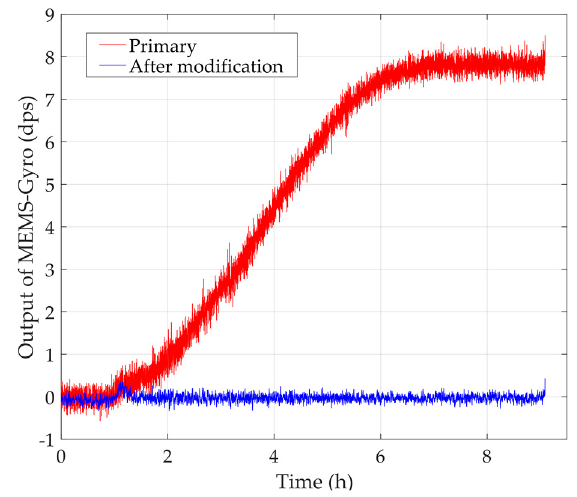
Figure 11. Primary outputs of MEMS-gyros and its compensated outputs.